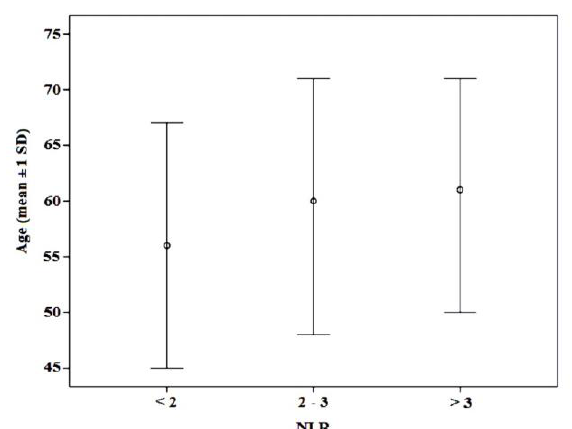
Figure 1. Association between the NLR and mean age; older people were in the high NLR